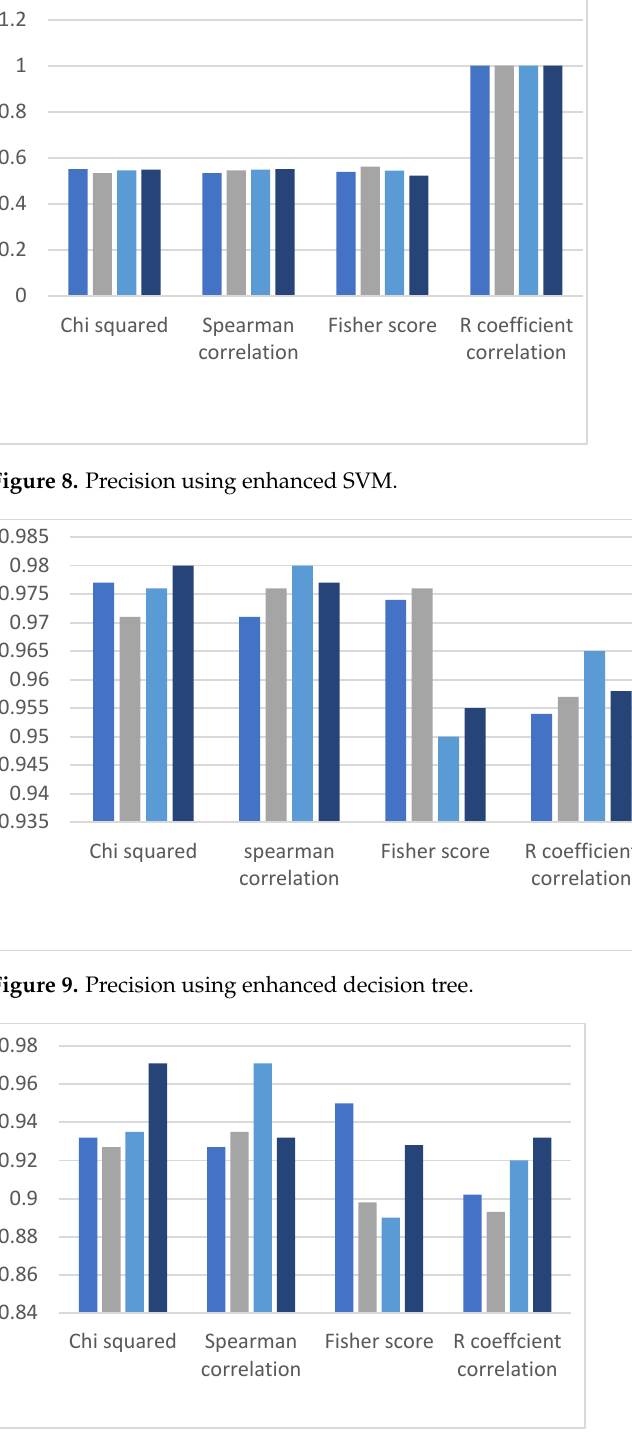
Figure 11. Precision using enhanced LR.